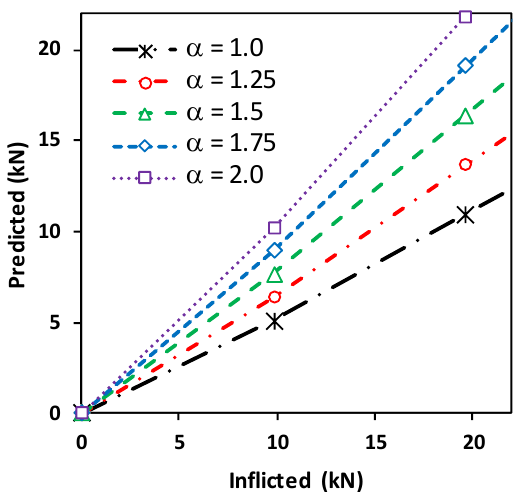
Figure 17. Prediction of tension force changes in the lab-scale cable structure: load transfer capability factor = 1 – 2.